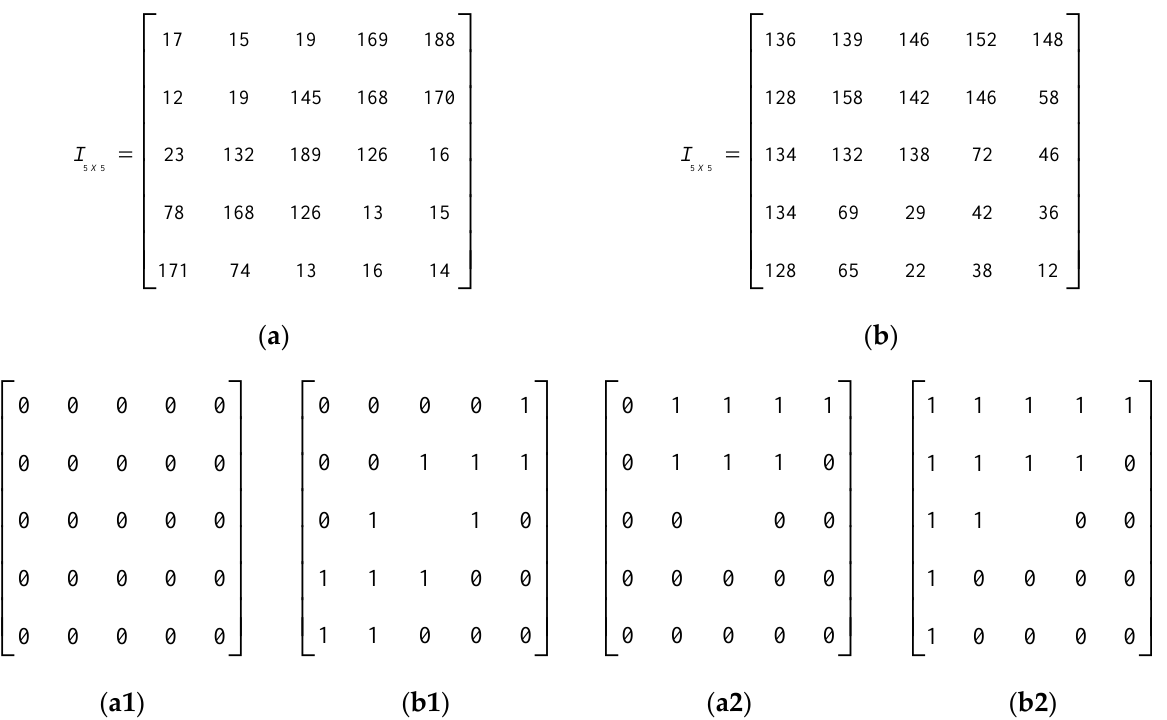
Figure 4. Three texture patterns and LBPs, AvN-LBPs. MBPs, and VAR values for the texture patterns.